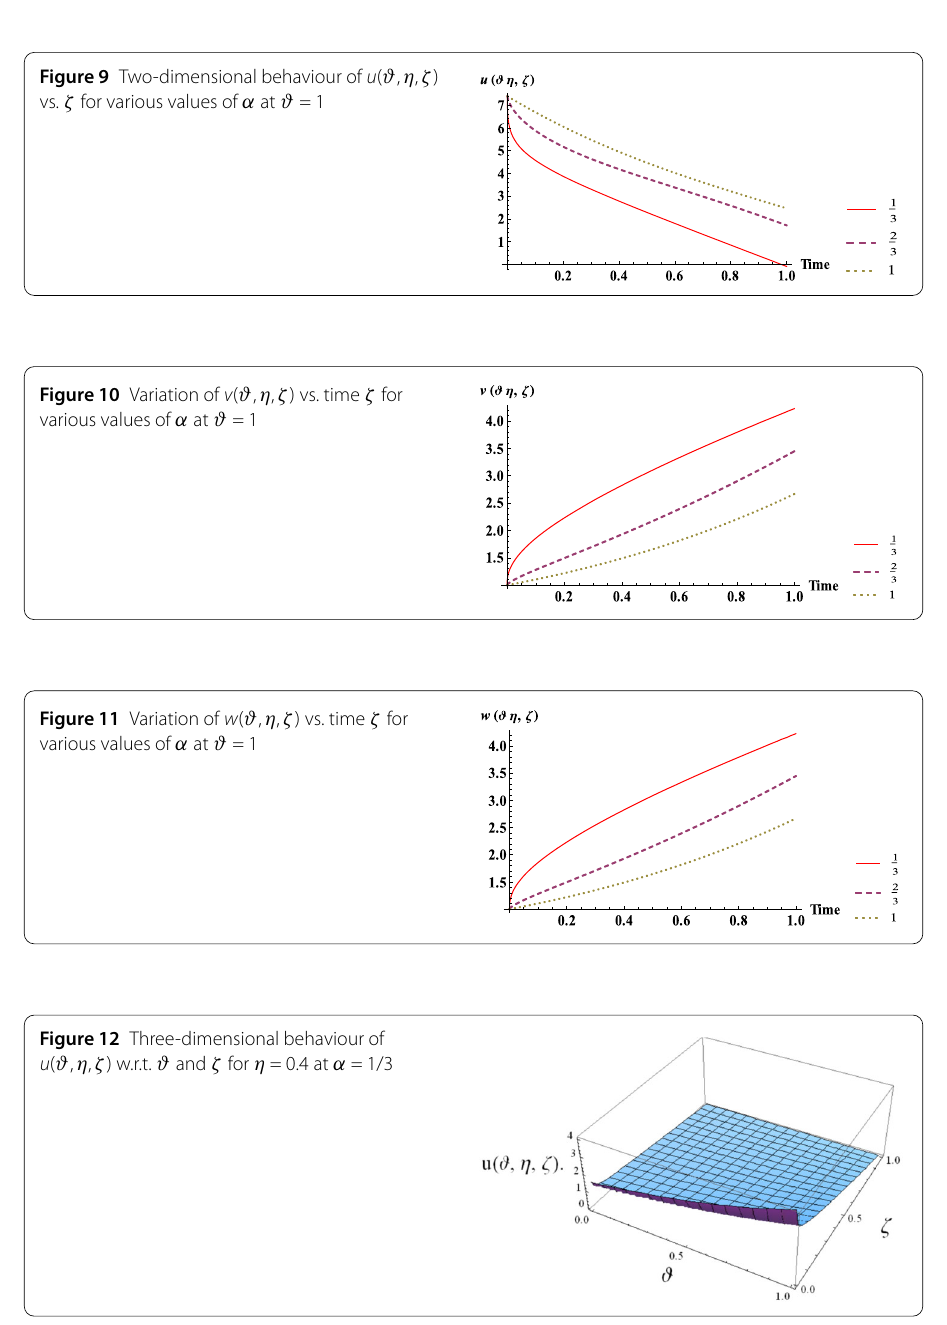
Figure 12 Three-dimensional behaviour of u ( ϑ , η , ζ ) w.r.t. ϑ and ζ for η = 0.4 at α =